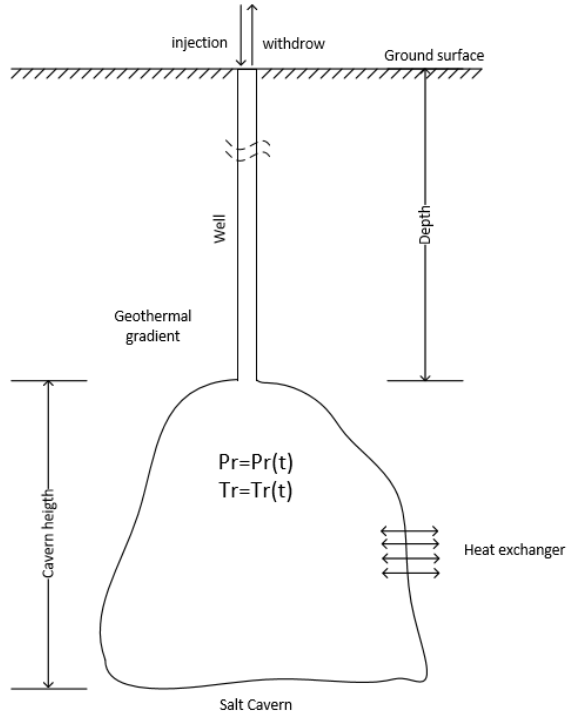
Figure 1. A simplified model of underground salt cavern gas storage.